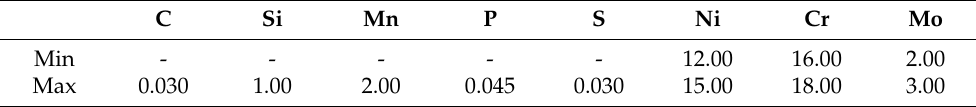
Table 2. Chemical composition thin metal foils of SUS 316